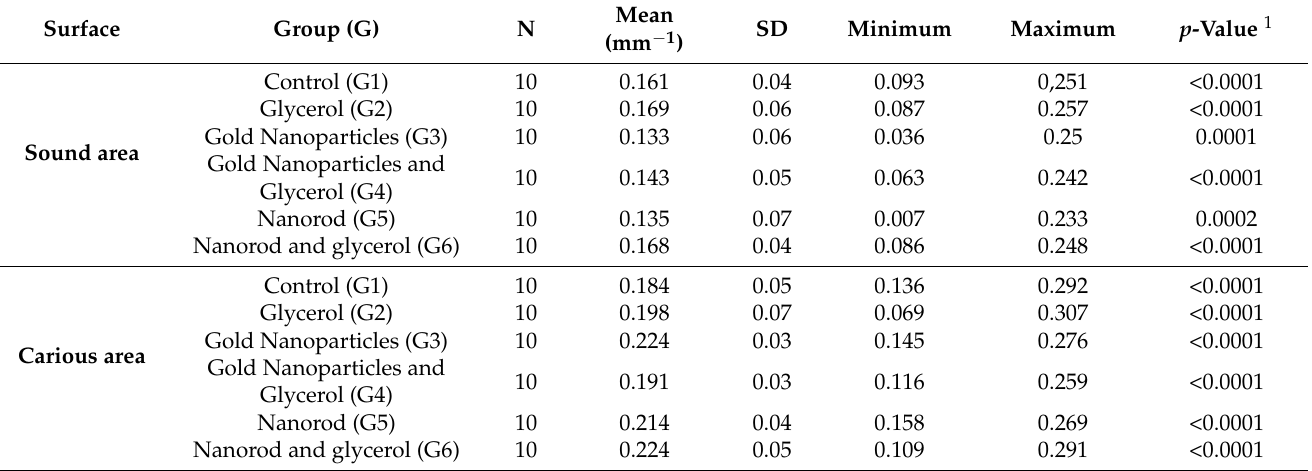
Figure 7. OCT B-scan images across occlusal surface of a molar, followed at right by the corresponding light intensity decay obtained from an A-scan of the region of interest (ROI) in the central pit area, according to OCAs used on the surface: ( a ) G1—Control; ( b ) G3—AuNPs; and ( c ) G6—AuNRs in glycerol. Table 1. Mean ± S.D. of the µ coefficient (mm − 1 ) values, taken from OCT images of sound and carious areas of teeth analyzed with optical clearing agents and contrast agents (OCA/CA). The RM-ANOVA analysis indicates that the values are not statistically different in the groups for sound and caries surfaces ( p >